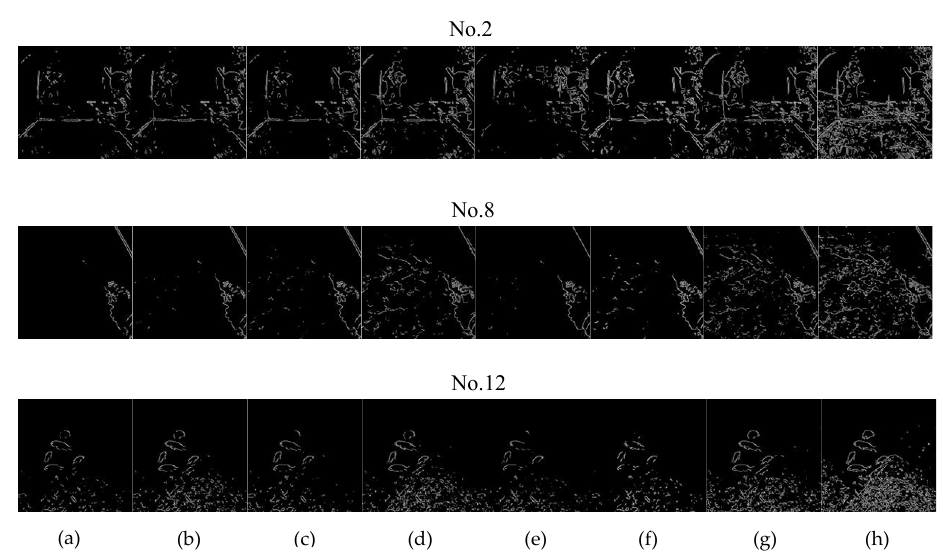
Figure 12. Edge detection results. ( a ) Underwater images from UIEB dataset; ( b ) processed by ICM; ( c ) processed by RCP; ( d ) processed by RGHS; ( e ) processed by MSRCR; ( f ) processed by FUnIE-GAN; ( g ) processed by UIE-CNN; and ( h ) processed by the proposed method.